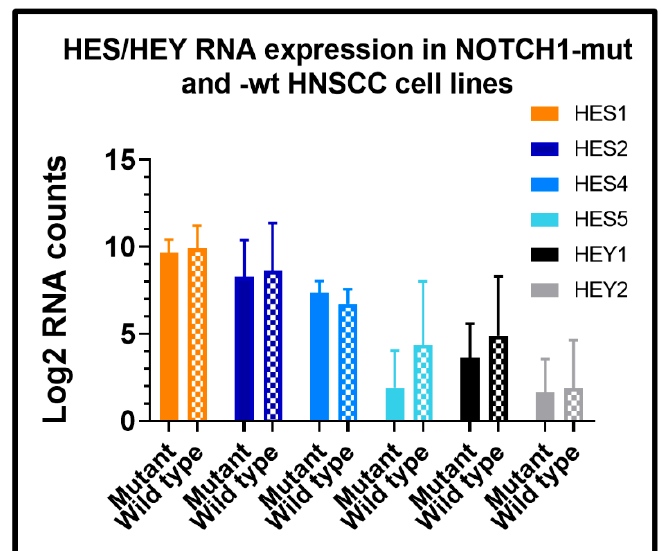
Figure 8. Expression of HES/HEY downstream targets is a poor surrogate for NOTCH1 pathway status. RNA expression of HES/HEY family members from five HNSCC cell lines with confirmed high levels of baseline ICN1 were compared to expression levels in six HNSCC cell lines with confirmed homozygous inactivating NOTCH1 mutations. Solid bars are mutant NOTCH1 averages ± standard deviation (sd); checkered bars are wt NOTCH1 averages ± sd. Levels of RNA were detected on an Affymetrix microarray in a large panel of HNSCC cell lines and counts subjected to upper quartile normalization before analysis. None of the differences in HES/HEY RNA expression was significantly different, but there was a trend towards increased HES5 and HEY in the NOTCH1 -wt cells (Table 2). HES3 RNA was not detected in any cells.